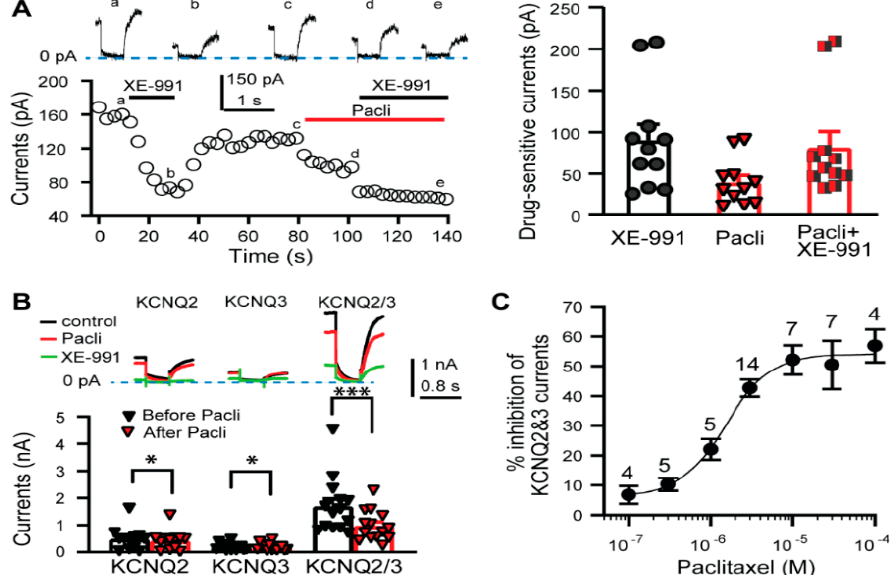
Figure 2. Paclitaxel inhibits KCNQ currents in isolated DRG neurons and Chinese hamster ovary (CHO) cells. ( A ) Representative traces and time course (left panel), as well as summary data (right panel), showing the effect of 10 µ M XE-991, 3 µ M paclitaxel, and their combination on the currents induced by hyperpolarization from − 20 to − 60 mV in isolated DRG neurons. Filled symbols in the bar graph represent individual DRG neurons. XE-991-sensitive currents = a − b, Pacli-sensitive currents = c − d, Pacli + XE-991-sensitive currents = c − e. p = 0.3405, F (2,30) = 1.117. One-way ANOVA used to compare the data in the bar graphs. ( B ) Current traces (upper panel) and bar graph (bottom panel) showing 3 µ M paclitaxel-induced inhibition of XE-991 (10 µ M)-sensitive currents in CHO cells overexpressing KCNQ2, KCNQ3, or KCNQ2/3 (1:1). Filled symbols in the bar graph represent individual CHO cells. p < 0.0001, t(11) = 3.025 for KCNQ2; p = 0.0387, t(13) = 2.3 for KCNQ3; p = 0.0002, t(13) = 5.266 for KCNQ2/3. Paired t test (two-tailed) used to compare the data in the bar graphs. ( C ) Scatter plot showing the effects of different concentrations of paclitaxel on the XE-991-sensitive current of CHO cells overexpressing KCNQ2/3 (1:1). The number above each point in the graph is the number of patched cells. Data are represented as mean ± SEM. *, p < 0.05; ***, p < 0.001. Pacli, paclitaxel.